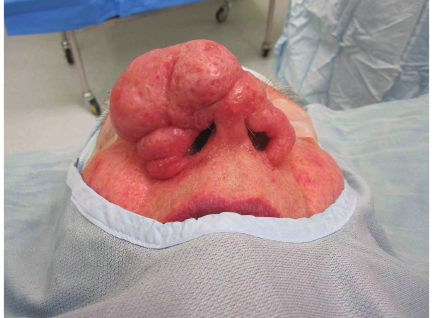
Figure 7: Case 3, intraoperative basal.